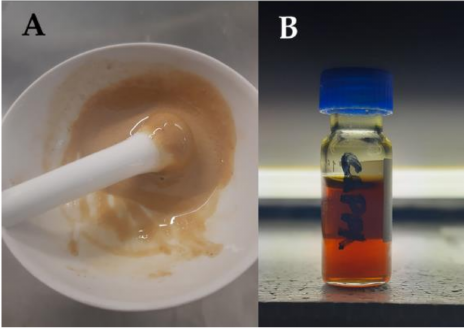
Figure 9. Image of the new DES obtained recycling the liquid fraction of wheat straw (WS) extract af- ter lignin precipitation: ( A ) preparation and ( B ) obtained ChPPh (choline chloride:polyphenols